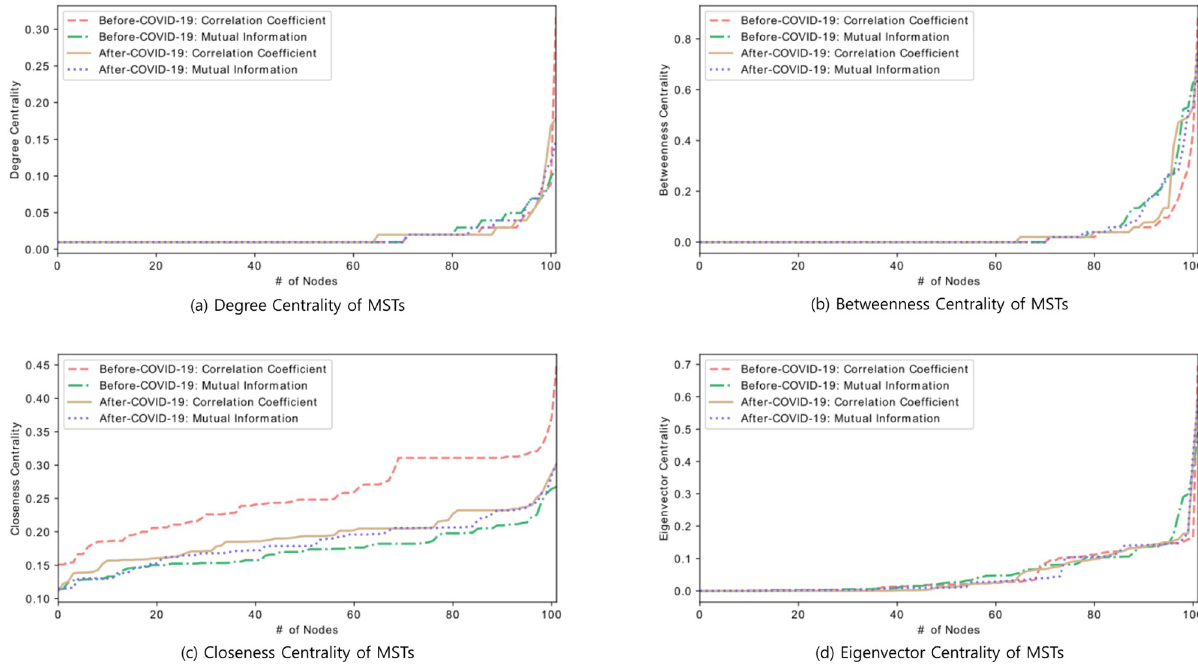
Fig 9. Four types of centrality measures in pre- and post-COVID-19